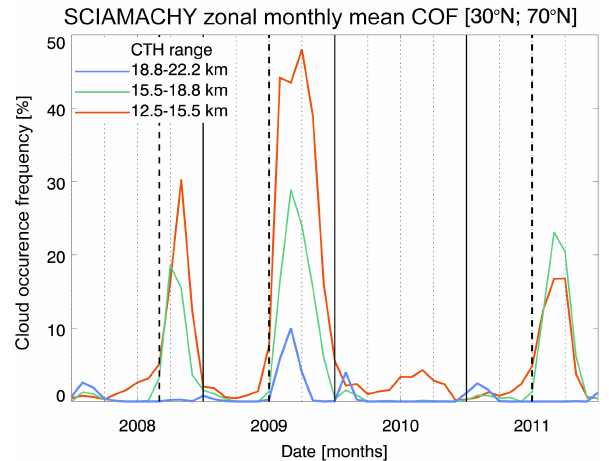
Figure 16. SCIAMACHY monthly zonal mean occurrence frequen- cies (in %) of cloud/aerosol scattering layers for the latitude band from 30 to 70 ◦ N for the years 2008–2011. Three different cloud top height layers of 12.5–15.5km (red line), 15.5–18.8km (green), and 18.8–22.2km (blue) are depicted. The vertical dashed line show the start months of the three major volcano outbreaks from Kasatochi, Sarychev peak, and